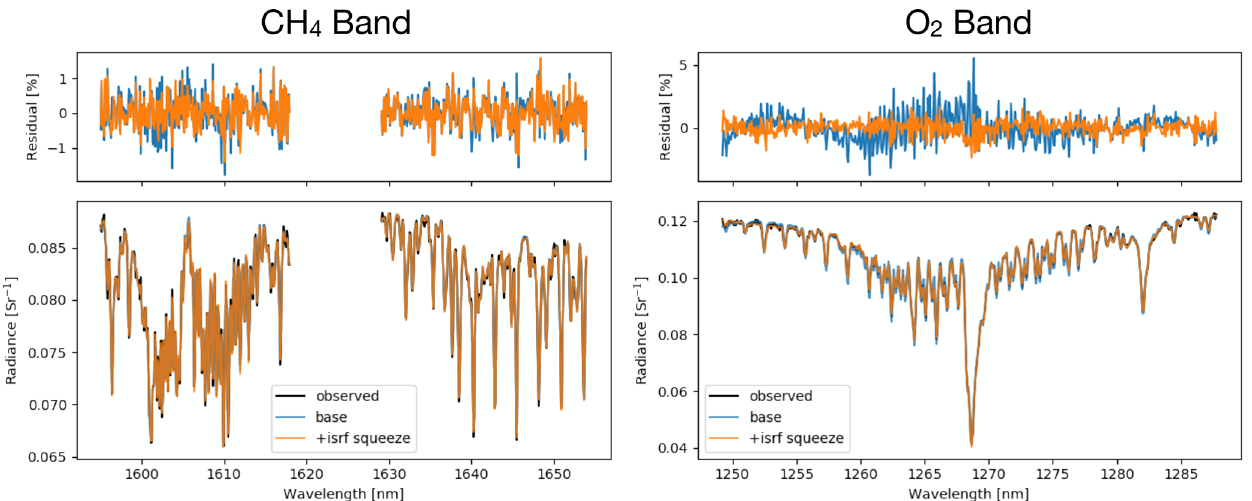
Figure 17. Spectral fits from MethaneAIR Research Flight 1 (11 August 2019, 18:36UTC) using the MethaneAIR optimal-estimation algorithm. Spectra are 10s along-track aggregates for spatial pixel 600 (approximate center of detector). Blue color indicates the fit and residual using the laboratory-calibrated ISRF lookup tables, and orange color indicates the fit and residual with an ISRF squeeze